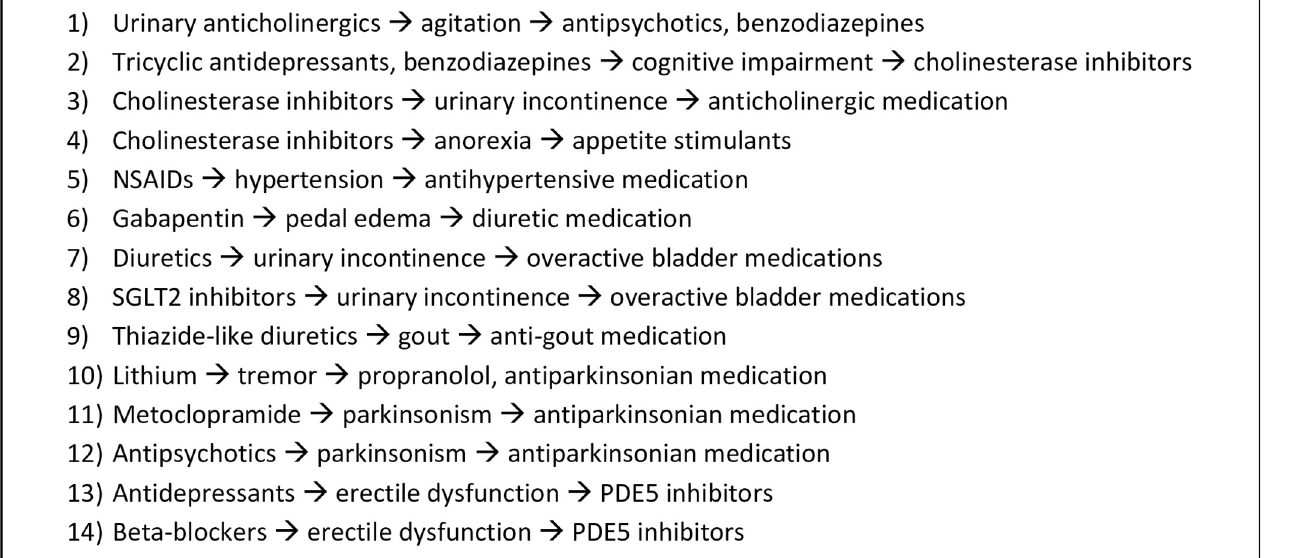
Fig 1. What are examples of prescribing cascades?